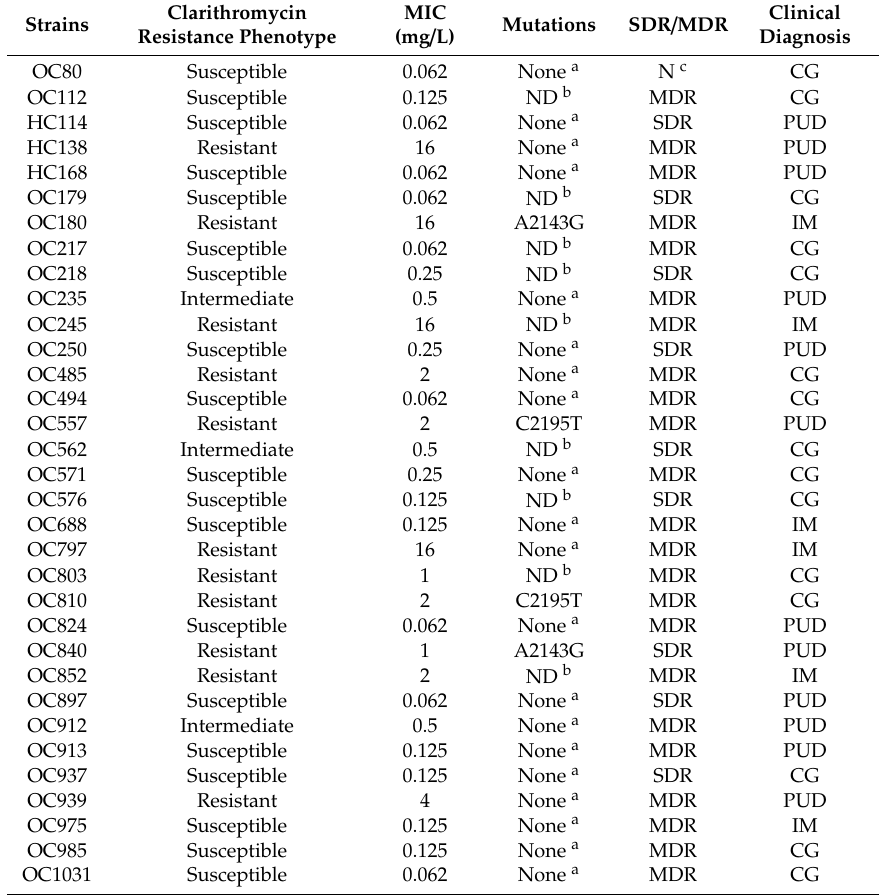
Table 7. Mutations in the 23S rRNA gene involved in clarithromycin resistance among H. pylori isolates used in this